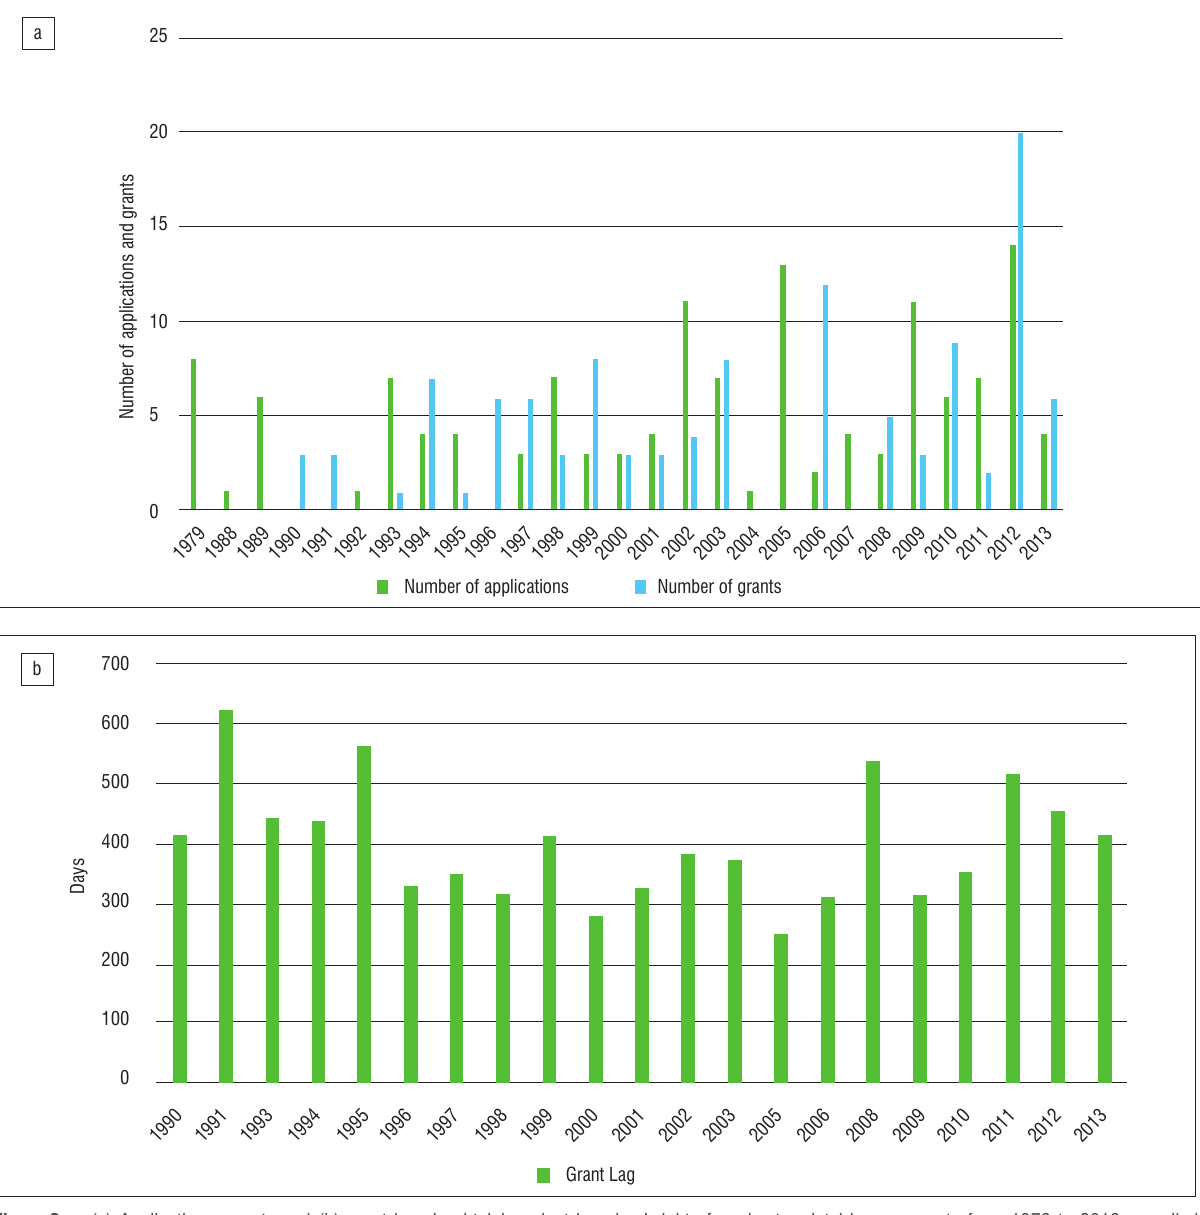
Figure 2: (a) Applications, grants and (b) grant lags in obtaining plant breeders’ rights for wheat varietal improvements from 1979 to 2013 compiled from data in South African Plant Variety